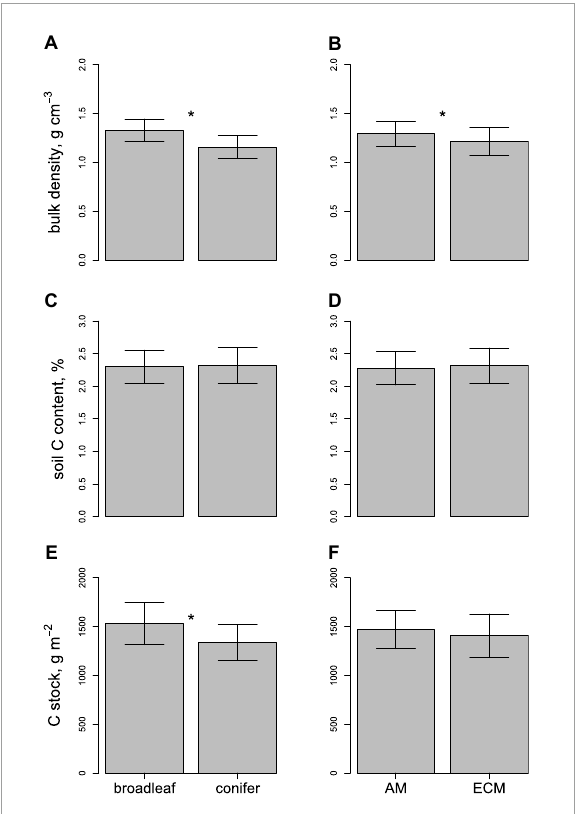
FIGURE1 Variation in soil properties (bulk density, carbon content, and carbon stocks) beneath different plant functional groups (Panels A,C , E) : broadleaves ( N = 32 observations) vs. conifers ( N = 44), (Panels B,D , F) : arbuscular mycorrhizal trees ( N = 16) vs. ectomycorrhizal trees ( N = 60). Asterisks indicate significant differences among groups in the ANCOVA models. All soils were sampled to 5 cm depth. Error bars represent ± 1